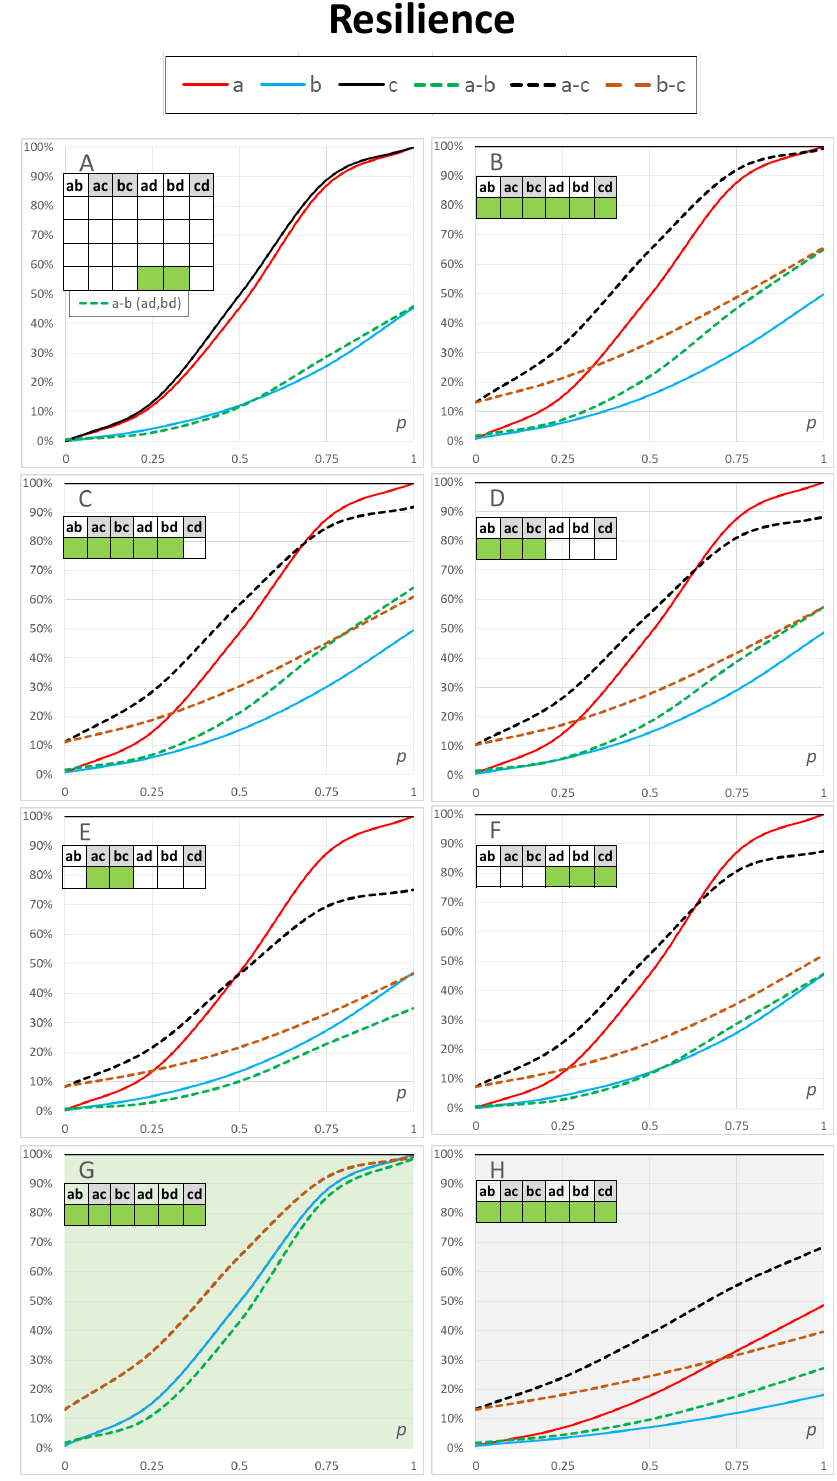
Figure 4. Resilience of the multilayer communication of Figure 1 with different resilience levels of communication within networks. Resilience values (probability of sufficient resilience) in each network are shown by solid lines a, b and c. Dashed lines a–b, a–c and b–c show corresponding resilience values between different networks. In this figure, the resilience between networks is kept constant and the resilience of connections between nodes in each network is varied (horizontal axis). ( G , H ) are explained in the